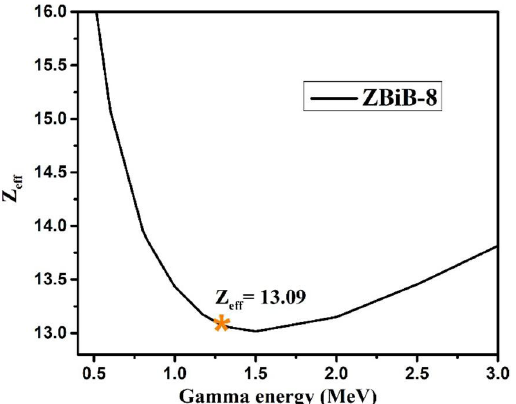
Figure 16. Effective atomic number of ZBiB-8 glass in the gamma energy range of 0.5- 3